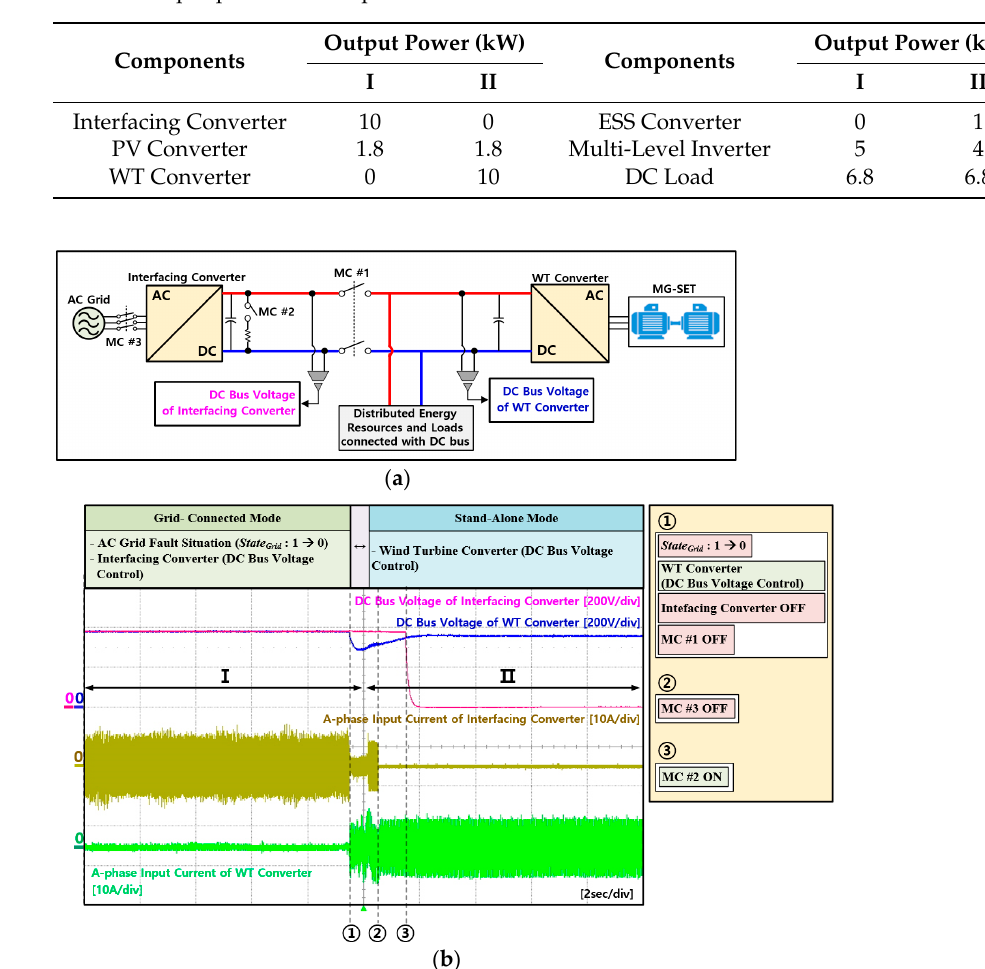
Figure 34. Experiment results of mode transition from grid-connected mode to stand-alone mode ( a ) configuration of experiment set-up, ( b ) waveforms of interfacing converter and WT converter. In the period I, it is assumed that the interfacing converter is operating in grid-con- nected mode, and the AC grid is disconnected at the point 1 At this time, the State Grid is changed to zero, and the WT converter performs DC bus voltage control for stand-alone mode operation. Interfacing converter stops operating at the same time. The MC #1 which is used to connect between the interfacing converter and DC bus is separated. At the point 2, the MC #3 on the AC grid side is separated. As a result, interfacing converter is com- pletely disconnected from the DC microgrid. At the point 3, the MC #2 is turned on to discharge the remaining DC capacitor voltage of the interfacing converter. After that, when the DC microgrid operates stably, the power consumed by the mul- tilevel inverter is reduced from 5 kW to 4 kW as shown in Figure 35. Therefore, 1 kW of surplus power remains, so this power is charged to the ESS as shown in Figure 36. Through this, it was verified that the stand-alone mode switching and the operation of mode 7 were performed stably. Figure 35. Experiment waveforms of DC load and multi-level inverter in mode 7.